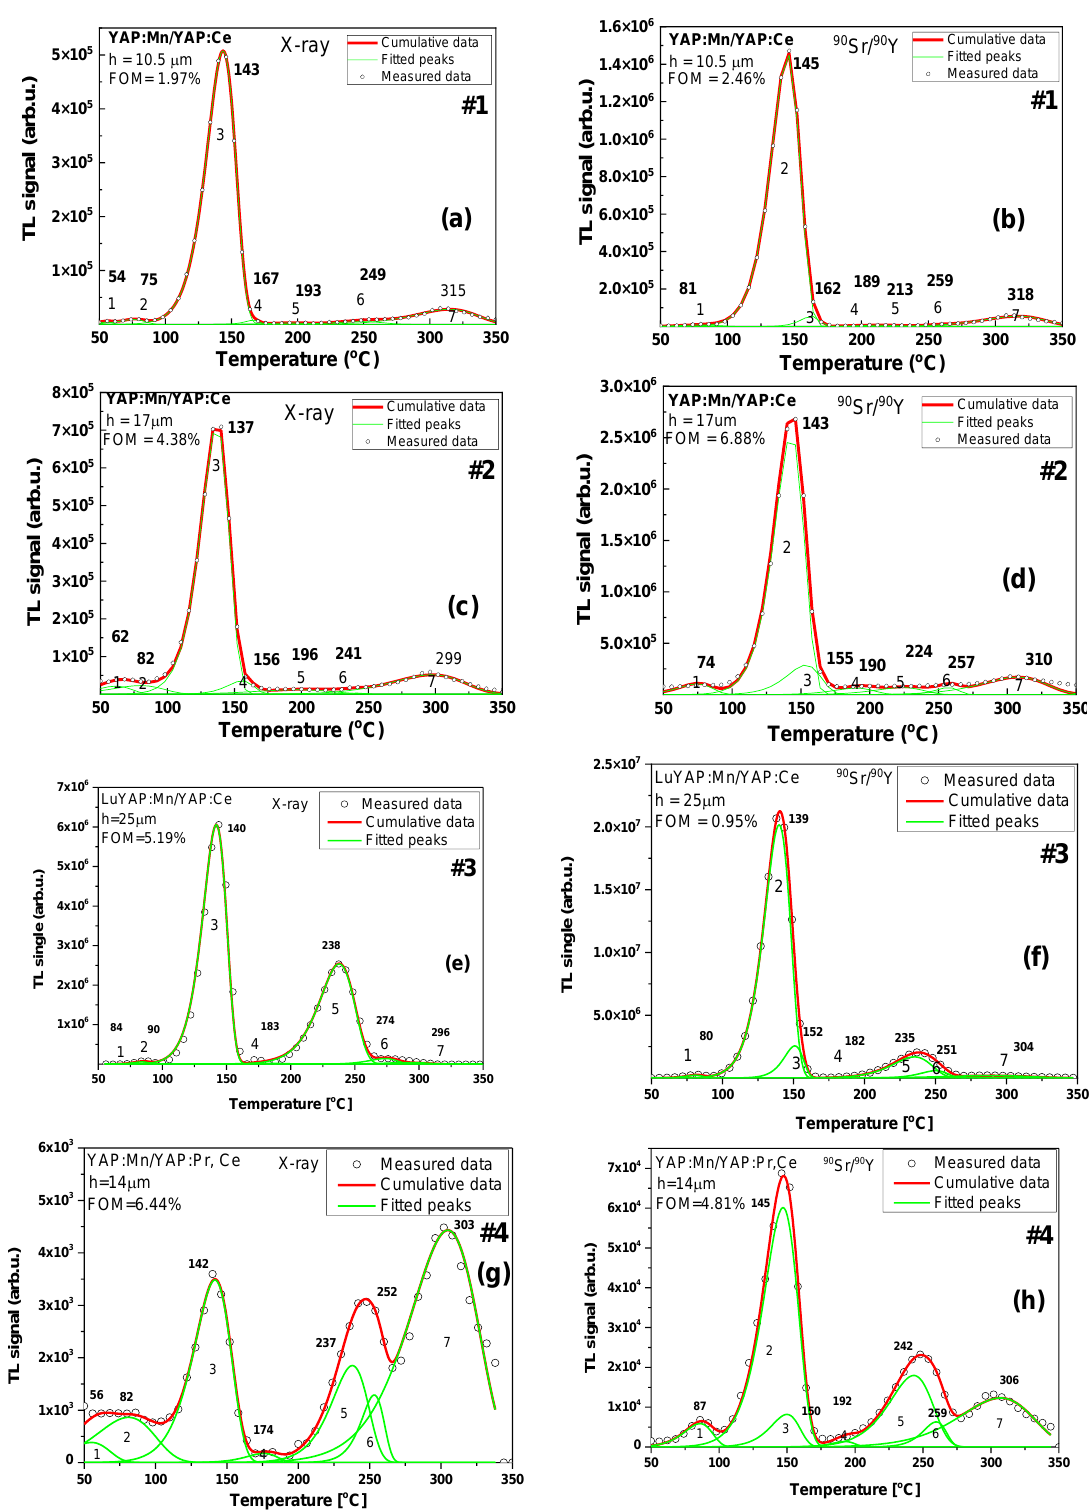
Figure 5. TL glow curves of samples #1, #2, #3, and #4 ( a – h ) after excitation by X- rays and β source.